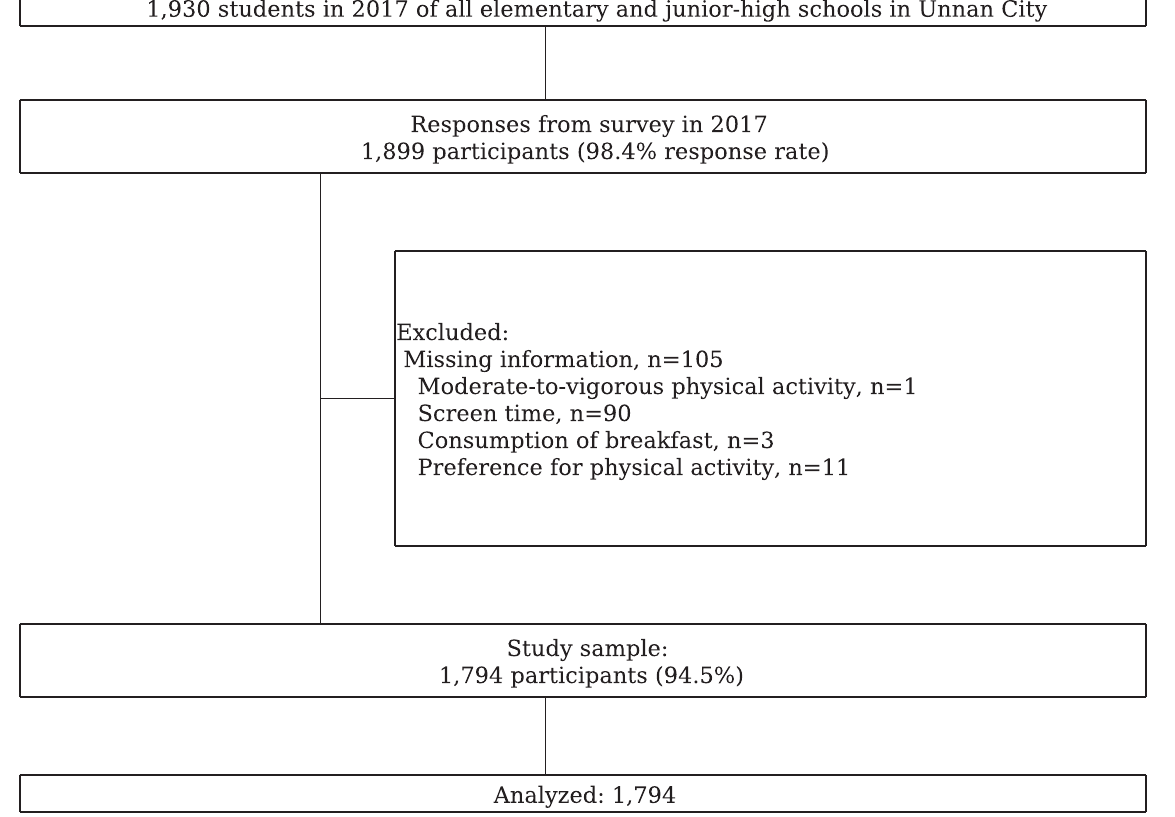
Figure 1. Flowchart of the